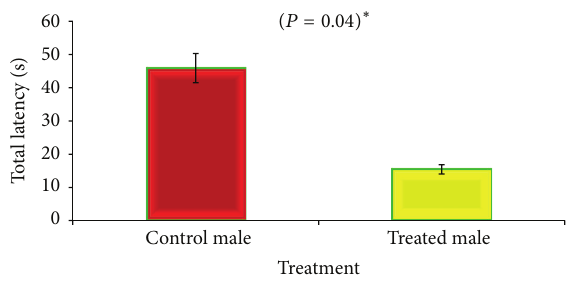
Figure 5: Comparison of total latency between GABA B antagonist and saline treated male albino mouse during probe trial of Morris Water Maze test. Data is expressed as mean ± standard deviation. 𝑃 value indicates the result of 2-sample 𝑡 -test.